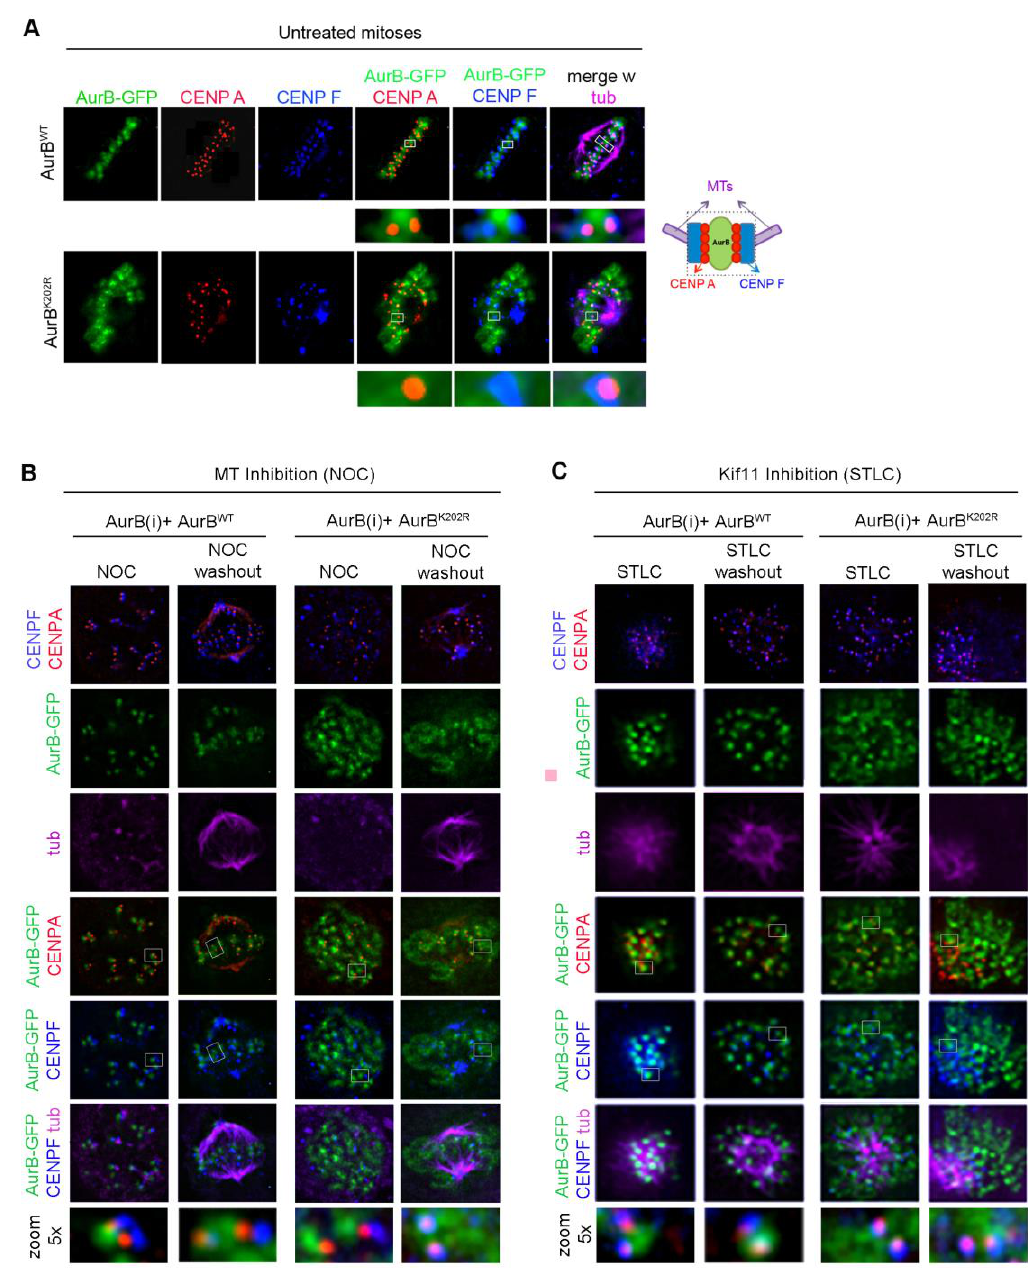
Figure 3. Aurora B K202R does not concentrate at centromeres. ( A ) Aurora B WT- GFP (top panel) and Aurora B K202R -GFP (bottom panel) in metaphase cells silenced for the endogenous Aurora B. In the blow-up (4 × ), Aurora B WT -GFP has a punctuated appearance bordered by CENP-A and, more externally, CENP-F (see schematics). Aurora B K202R -GFP (bottom panel) shows a more diffuse pattern over chromosomes. ( B ) Aurora B K202R fails to concentrate near CENP-A, independent of the absence (NOC) or presence (NOC release) of kinetochore attachments to microtubules. ( C ) Localisation of Aurora B, CENP-A and CENP-F, in kif11-inhibited cells (STLC) with unseparated poles and stretched kinetochores, or in STLC-released cells with stimulated Aurora B activity. Under all conditions, the K202R mutation impairs Aurora B concentration at centromeres, as can be appreciated in the magnification (bottom panels).